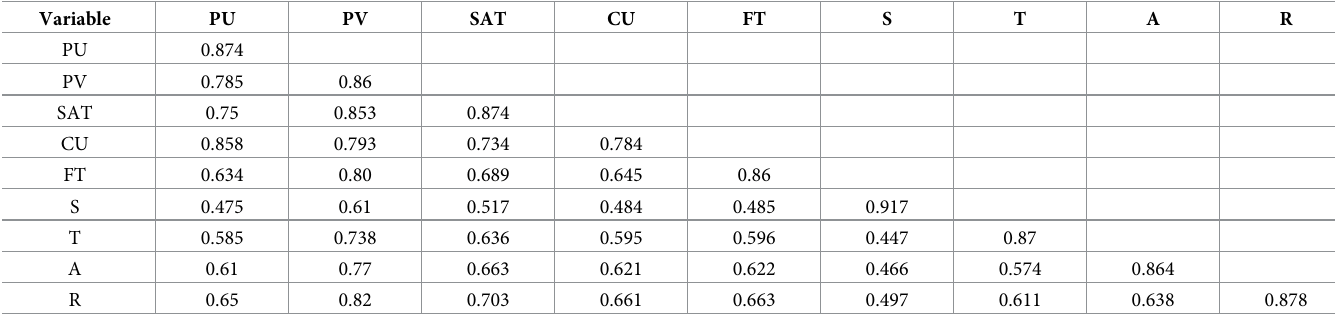
Table 11. Differential validity